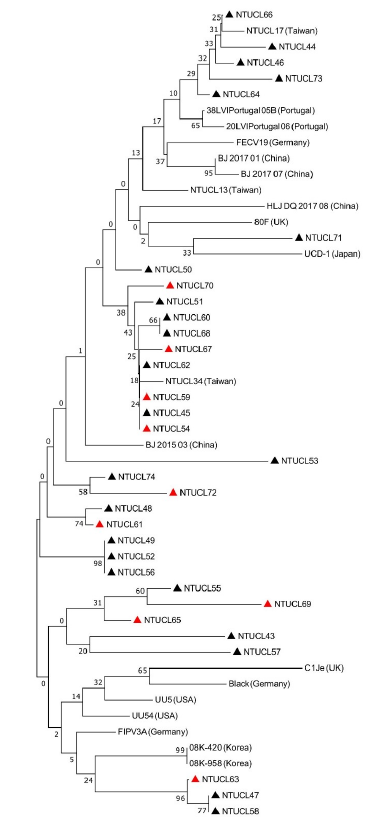
Microorganisms 2021 , 9 , x FOR PEER REVIEW